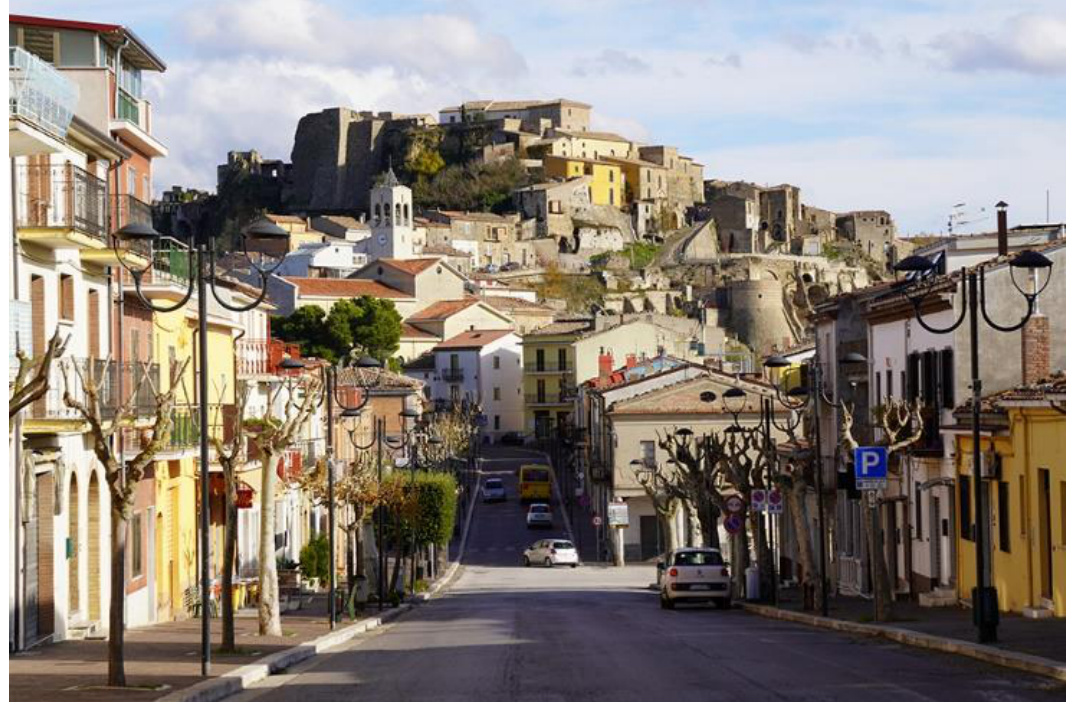
Figure 114. Calitri: panoramic view of the new constructions, the historical centre and the remains of the castle on the hill (photos by [35,36]).